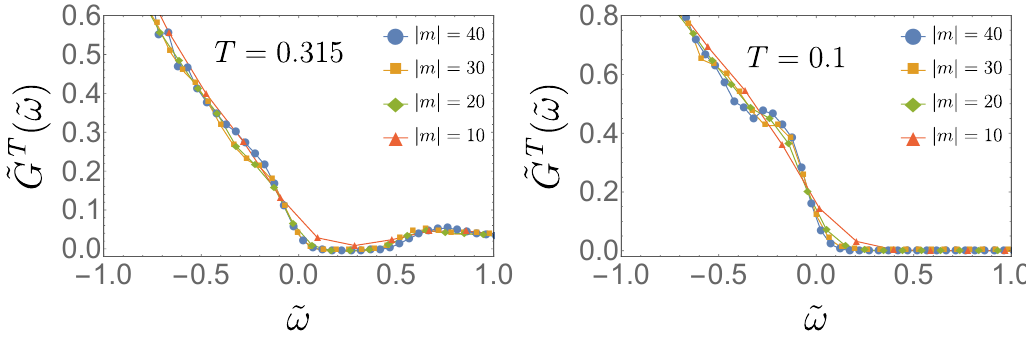
Figure 5: (color online) The power spectra of interacting Rindler Dirac fermions for a thermal background (74) at T = 0.315 (left panel) and T = 0.1 (right panel). We consider here a square lattice on a cylinder (open boundary conditions along x ) of lengths 100 × 100, with the Rindler horizon laying on the circle along y at the half of the cylinder. For each value of the | m | , the ˜ G ( ˜ ω ) are convoluted with a Gaussian filter of 2-site width centered around m . The temperature T values were chosen such that ∆ ( T = 0.315 ) ≈ 0.25 and ∆ ( T = 0.1 ) ≈ 0.5 in order to directly compare with the results in Fig. 3 at T = 0. As expected, the effect of a thermal background becomes more significant when the ratio T / ∆ ( T ) becomes of order